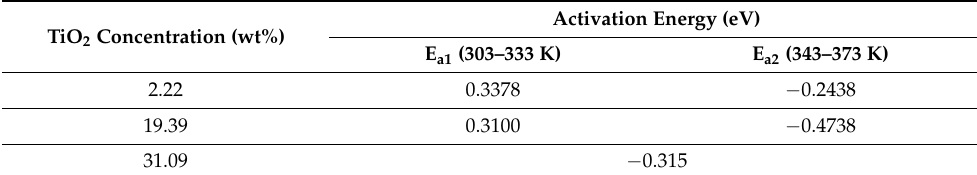
Table 4. Activation energies for the nanocomposite